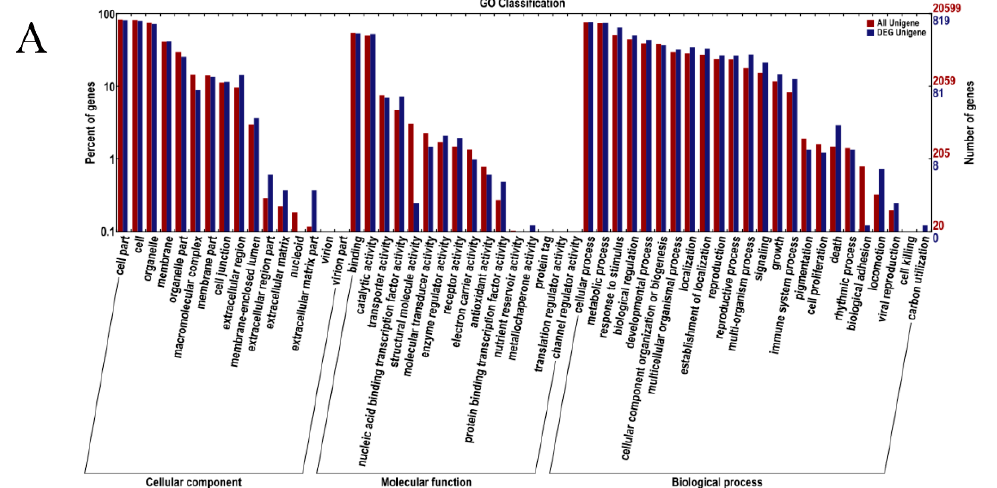
Figure 3. Cont. Figure 3. Cont